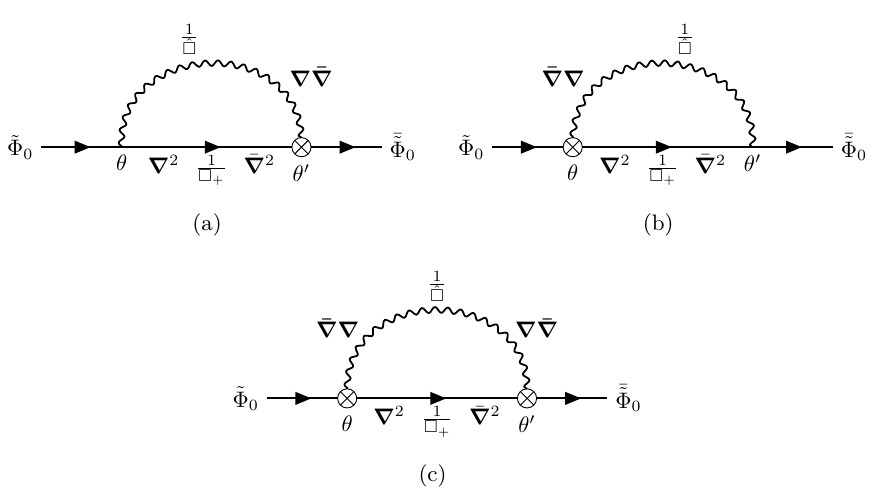
Figure 10 . Novel one-loop self-energy diagrams containing three-point vertices originating from the expansion of the geometric series (5.22). The assignment of momenta is the same as in figure 4.